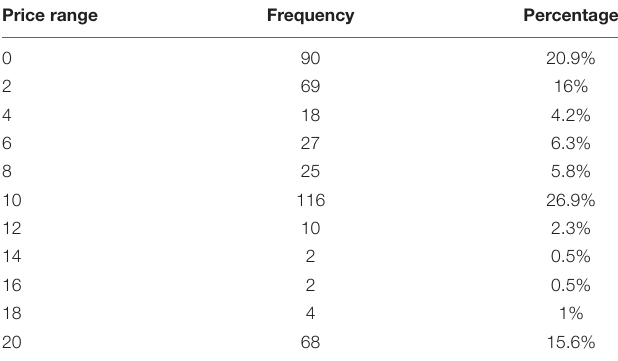
TABLE 2 | Results of willingness to